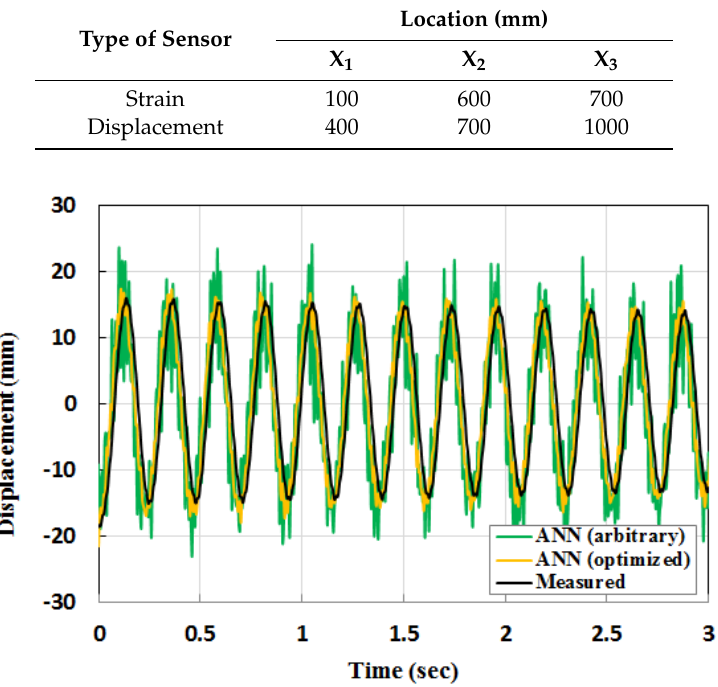
Figure 21. Overall displacements shape at time = 1.5 s. 6. Conclusions In this study, a method for optimizing the number and locations of strain-measurement points required for predicting displacements was newly proposed. The ANN’s ability for data mapping was used to define the relation between strain and displacements. Additionally, the GA’s ability for global search was used to optimize the strain-measurement points because the displacement prediction accuracy of the ANN varies according to the number and locations of strain-measurement points. The proposed method was verified for two cases by using a simple beam under a sinusoidal load and a bridge under a vehicle load. Also, the proposed method was applied to a vibrating cantilever beam. From the results, the following conclusions can be drawn: (1) The ANN prediction accuracy can be improved by optimizing the ANN input values using GA. In this study, the number and locations of strains were optimized to accurately predict displacements. The optimization results show that at least two strains at the optimized locations are sufficient to predict the displacements; (2) By comparing the ANN displacement prediction results from the strain at the optimized locations and the strain at the arbitrary locations, the difference between the MSE and the R value was found. In particular, the difference was prominent in the graph. Therefore, if the